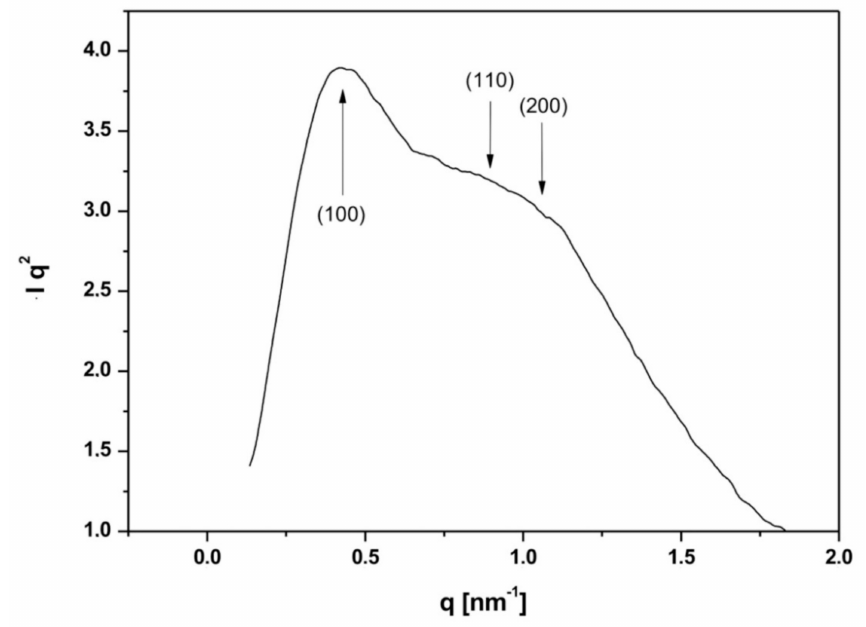
Figure 2. SAXS di ff ractogram of SiO 2 _w NPs.